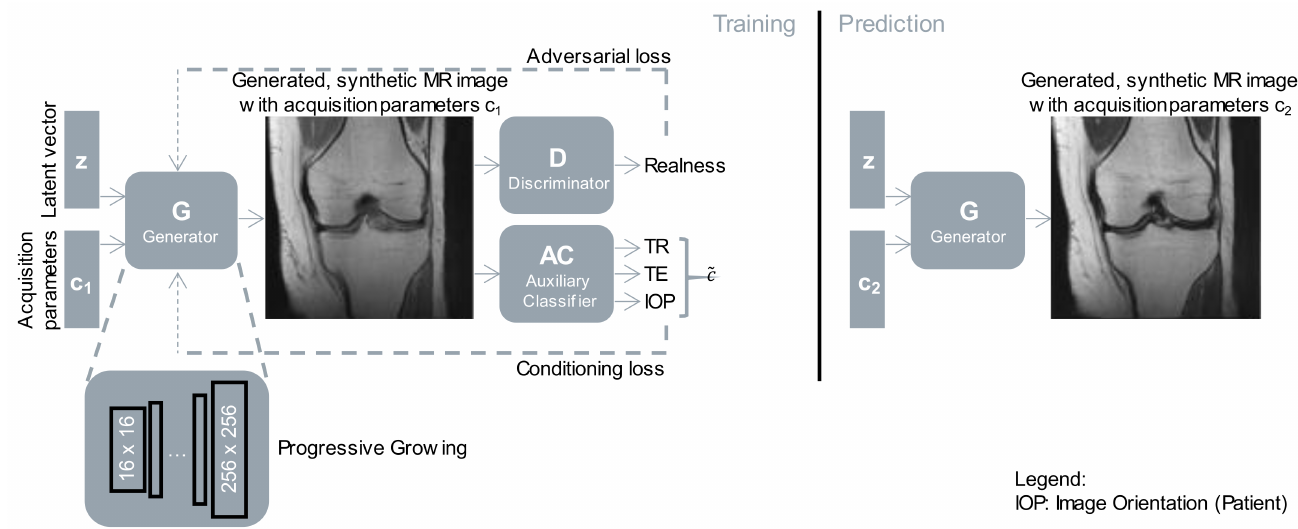
Figure 2. Training and inference phase of our GAN. The generator was trained to synthesize MR images for a given latent vector z and a set of acquisition parameters c 1 , guided by two networks, the discriminator, and the auxiliary classifier. After training, a synthetic MR image can be generated for a given latent vector z with any acquisition parameters c 2 (prediction phase). The shown images were generated for a random latent vector with two different sets of acquisition parameters (represented by c 1 , c 2 ), corresponding to coronal imaging orientation, and a TR of 3000 ms, TE of 15 ms, and 45 ms for c 1 and c 2